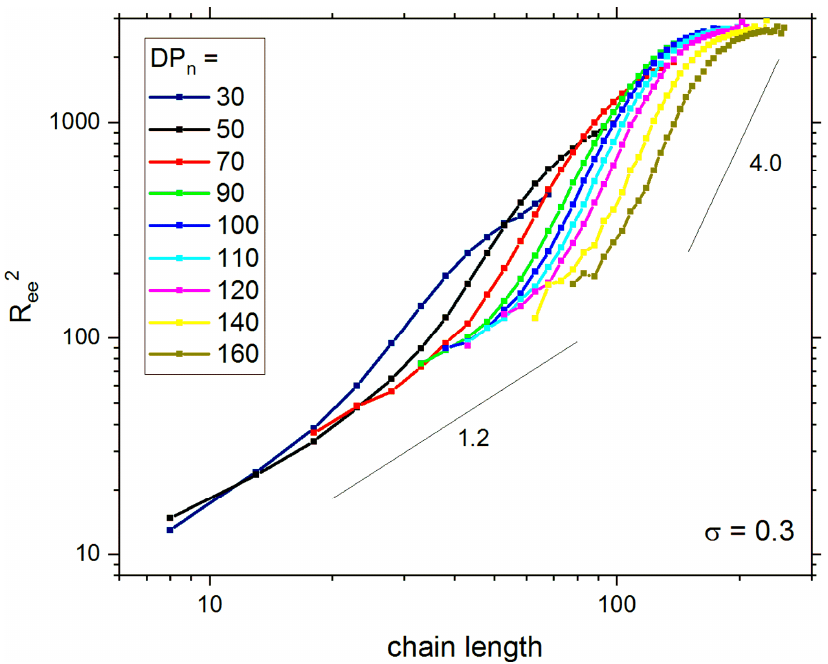
Figure 4. Mean squared end-to-end distance R 2 ee in lattice constants as a function of chain length m . The values of DP n are displayed in the inset.